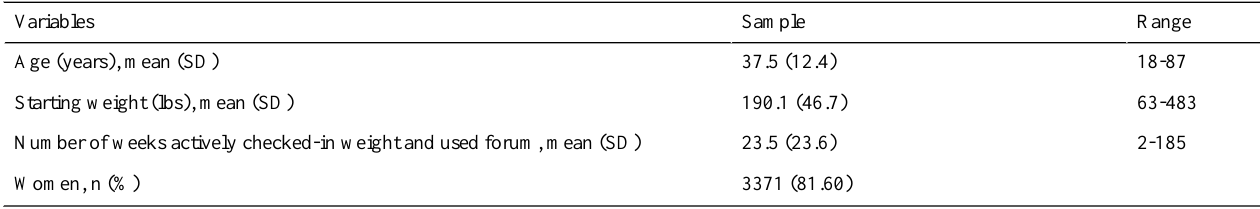
Table 1. Descriptive statistics of the sample (N=4132). a